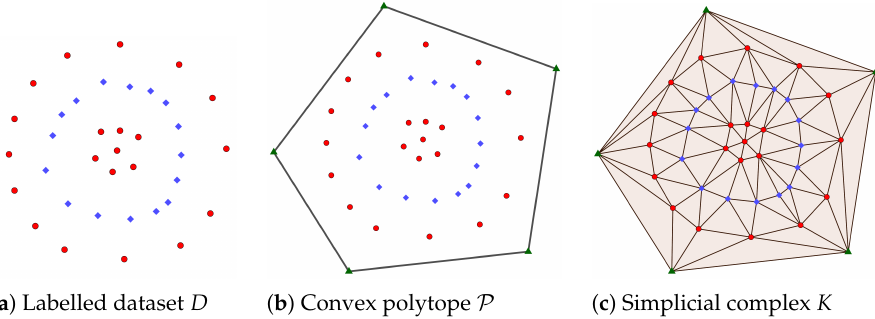
Figure 2. Given a labelled dataset D , a convex polytope P containing D can be computed. Then, the simplicial complex K can be obtained using the Delaunay triangulation of all the points of D and the vertices of P